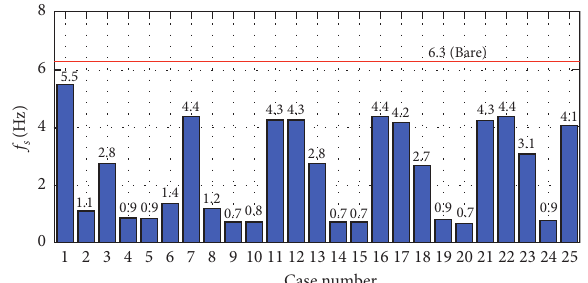
Figure 11: The values of f s with different case number.